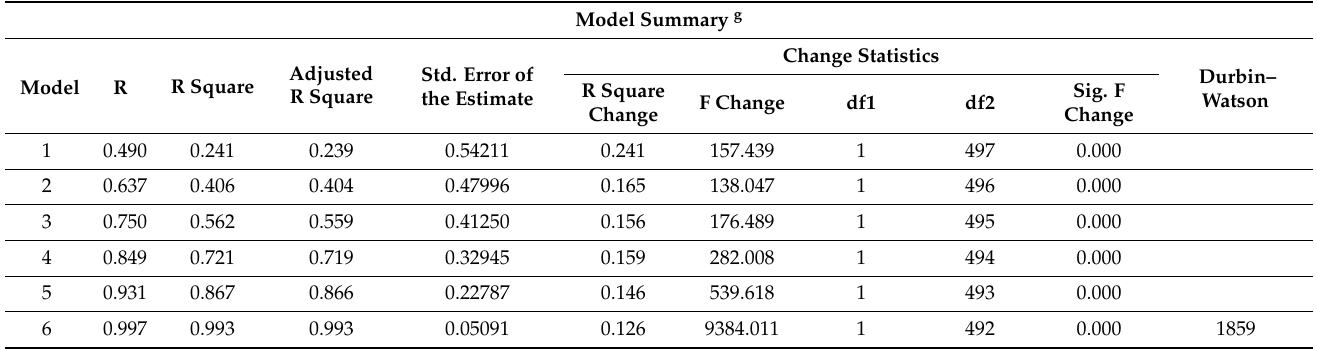
Table 7. Durbin–Watson test.